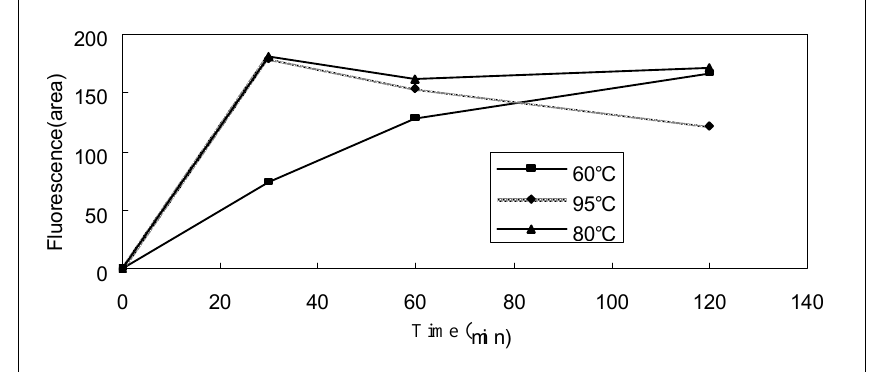
Figure 2. Effect of time and temperature on the derivatization